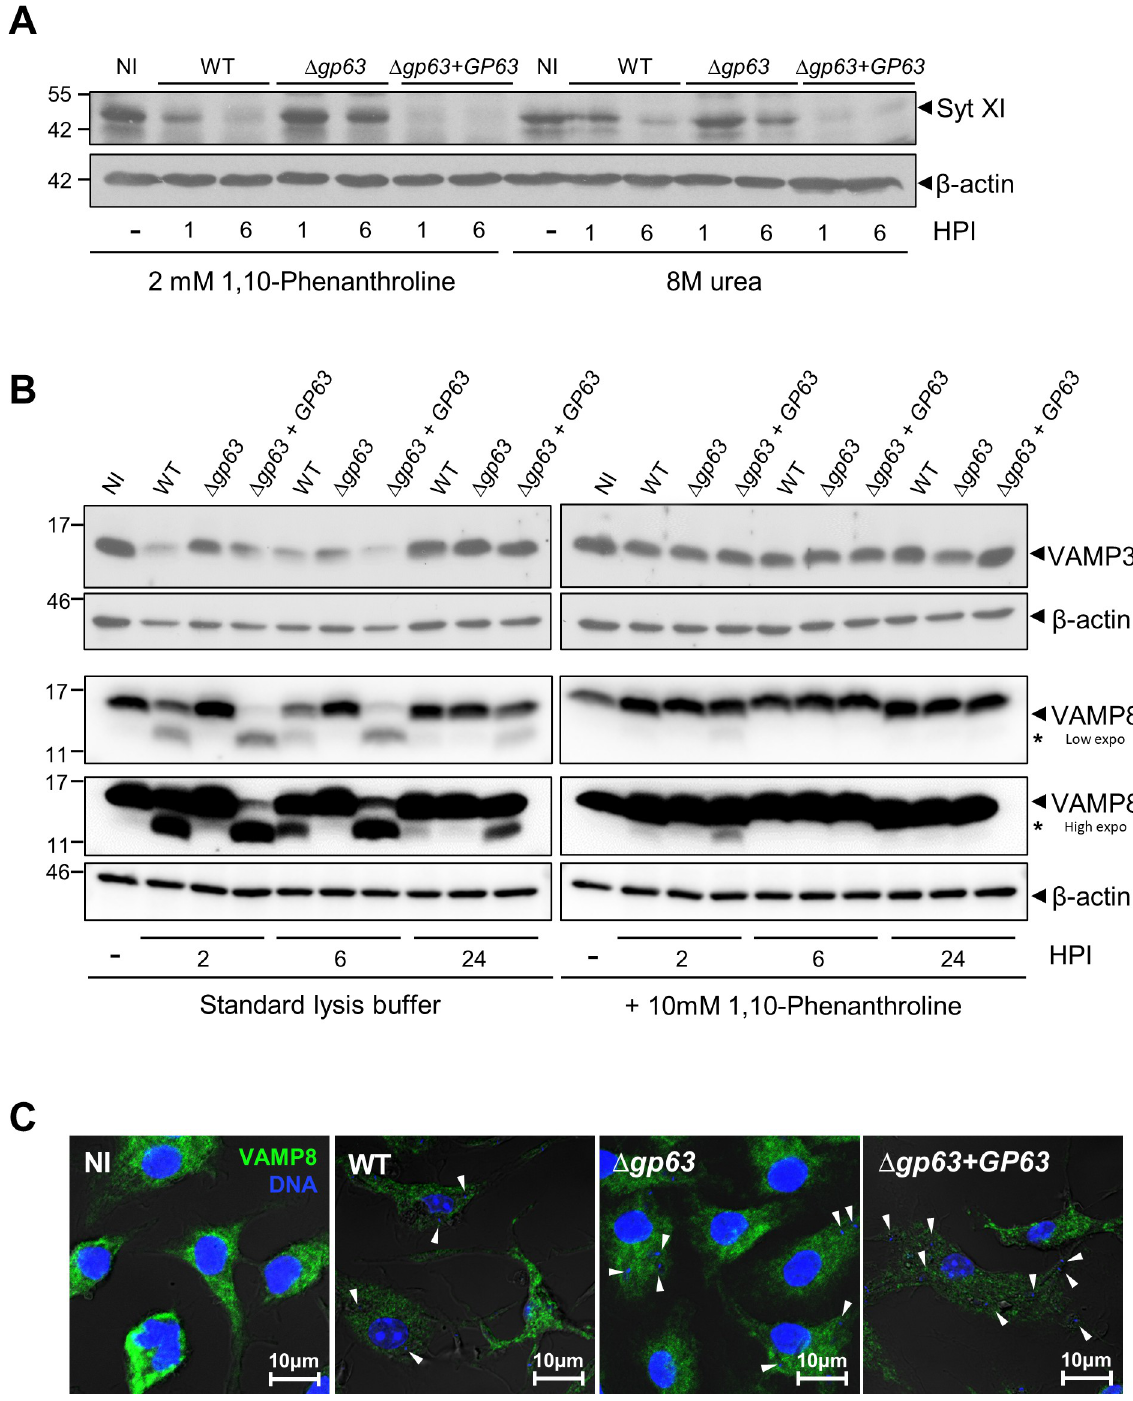
Fig 4. Syt XI and VAMP8 are bona fide GP63 substrates. A. Lysates of uninfected BMM (0 h post-infection) or BMM infected with either WT, Δ gp63 , or Δ gp63 + GP63 L . major metacyclic promastigotes were prepared at the indicated time points in lysis buffer containing 2 mM 1,10-phenanthroline or were lysed directly in 8 M urea. Levels and integrity of Syt XI were assessed by Western blot analysis. β -actin was used a loading control. B. Lysates of uninfected BMM (0 h post-infection) or BMM infected with either WT, Δ gp63 , or Δ gp63 + GP63 L . major metacyclic promastigotes were prepared at the indicated time points in standard lysis buffer or in lysis buffer containing 10 mM 1,10-phenanthroline. Levels and integrity of VAMP3 and VAMP8 were assessed by Western blot analysis. A low and an high exposure anti- VAMP8 blots are shown. β -actin was used a loading control. Asterisk denotes cleavage fragments. Immunoblots shown are representative of at